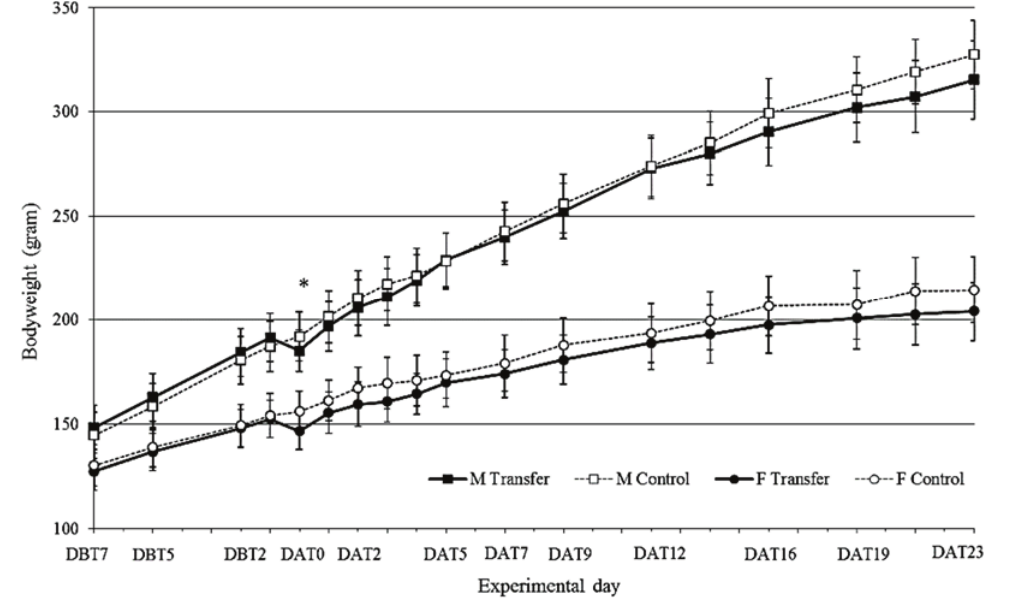
Figure 1. Body Weight (gram ± standard deviation (SD)) in male (squares) and female (circles), transferred (black symbols-solid line) and control (white symbols-dotted line) rats, 7 days before (DBT) until 23 days after (DAT) transfer ( n = 8). * indicates significant different growth between transferred (TF) and control (CO)